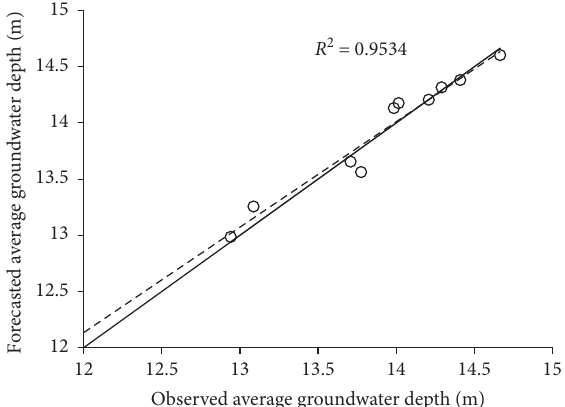
Figure 8: Scatterplot comparing observed and forecasted average groundwater depth using the best WA-ARMA-BP model during the testing period.